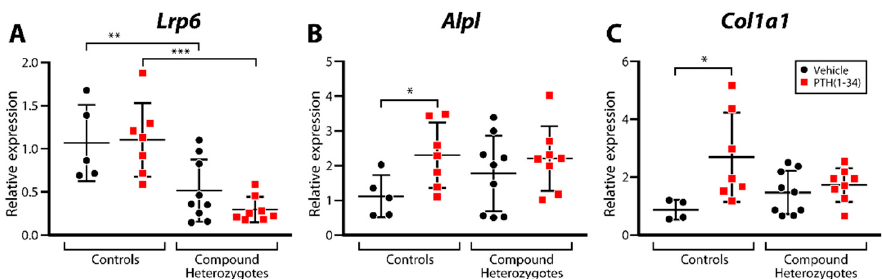
Figure 5. Gene expression monitoring in control ( Naca 99S/S ; Lrp6 +/+ ;OCN-Cre) and compound heterozygous ( Naca 99S/A ; Lrp6 +/fl ;OCN-Cre) littermates. RNA was extracted from marrow-flushed tibial diaphyses, reverse-transcribed and analyzed by RT-qPCR. Relative expression of Lrp6 ( A ), Alpl ( B ) and Col1a1 ( C ) is shown. * p < 0.05; ** p < 0.01; *** p < 0.001, two-way ANOVA with post hoc tests.